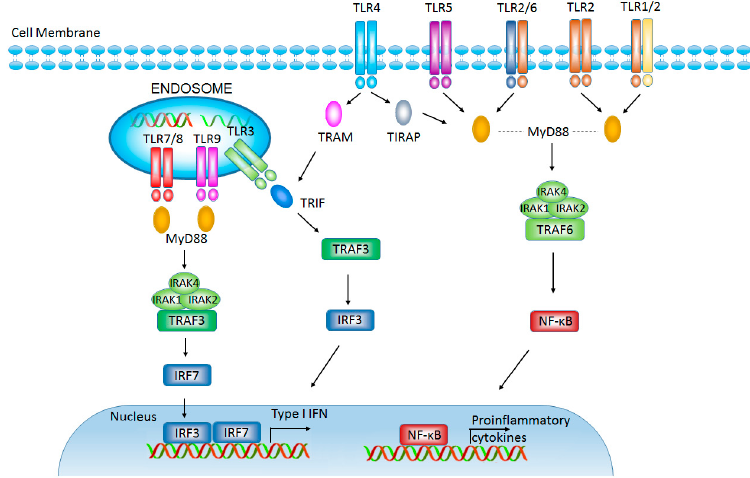
Figure 1. Toll-like receptors (TLRs) and TLR-mediated signaling pathway. TLR3, TLR4, TLR5, TLR7,